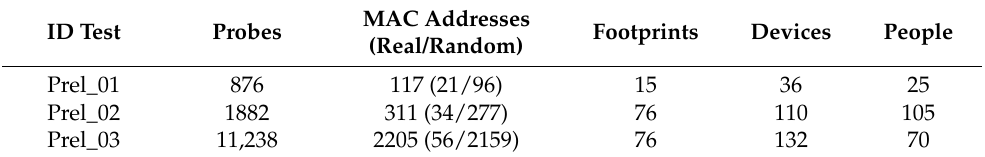
Table 3. Preliminary experiments’